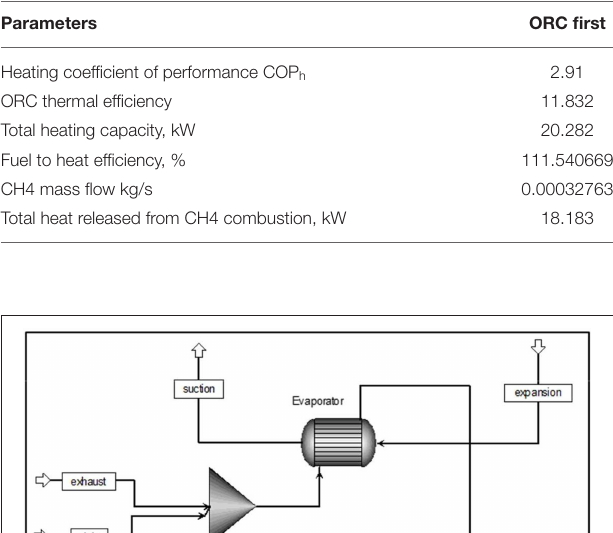
TABLE 2 | Cycle efficiency and gas burner design parameters.